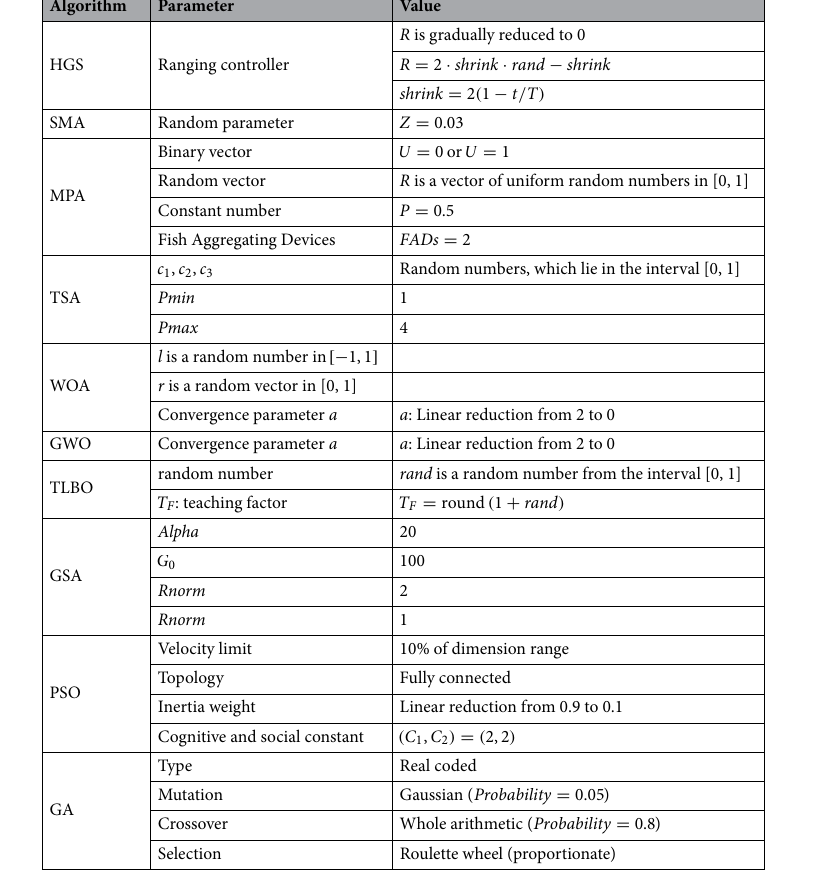
Table 1. Adjusted values of the control parameters of ten competitor